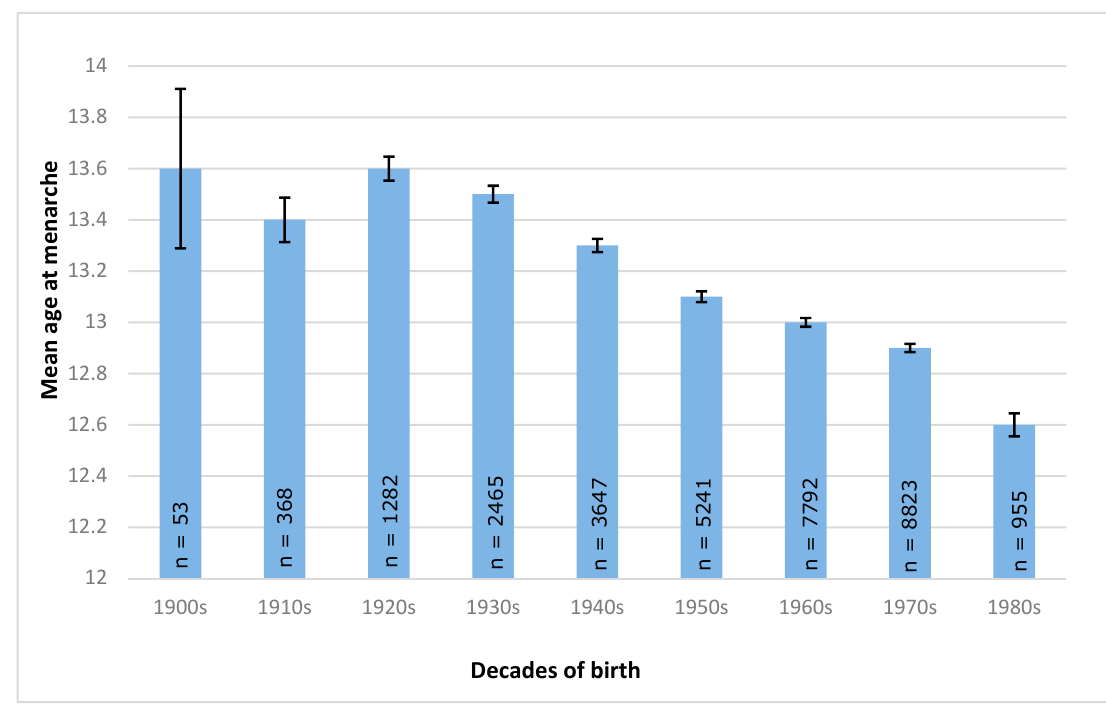
Figure 2. Mean age at menarche per decade of birth (1900s–1980s).